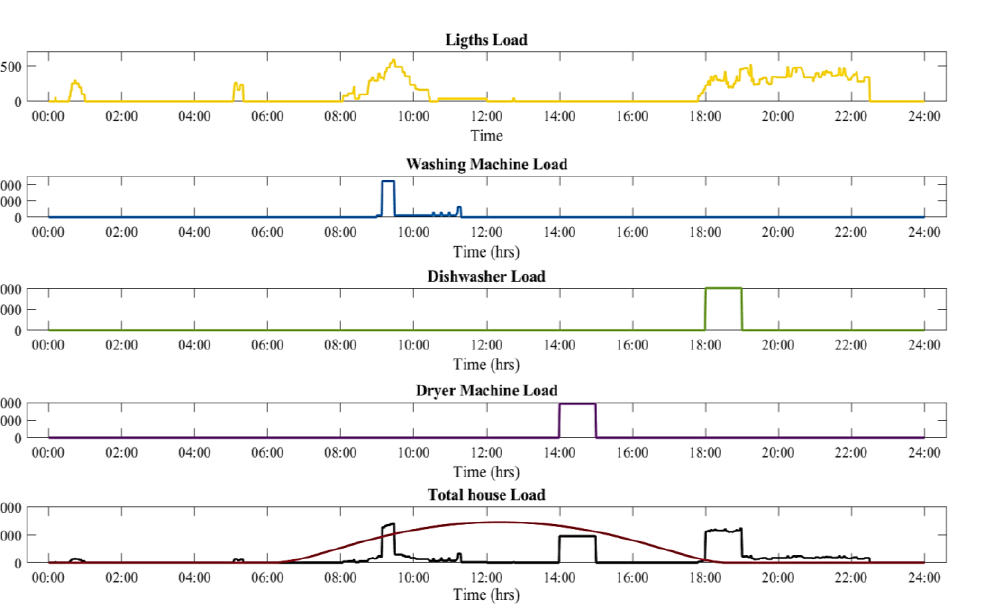
Figure 6. Example appliances load.